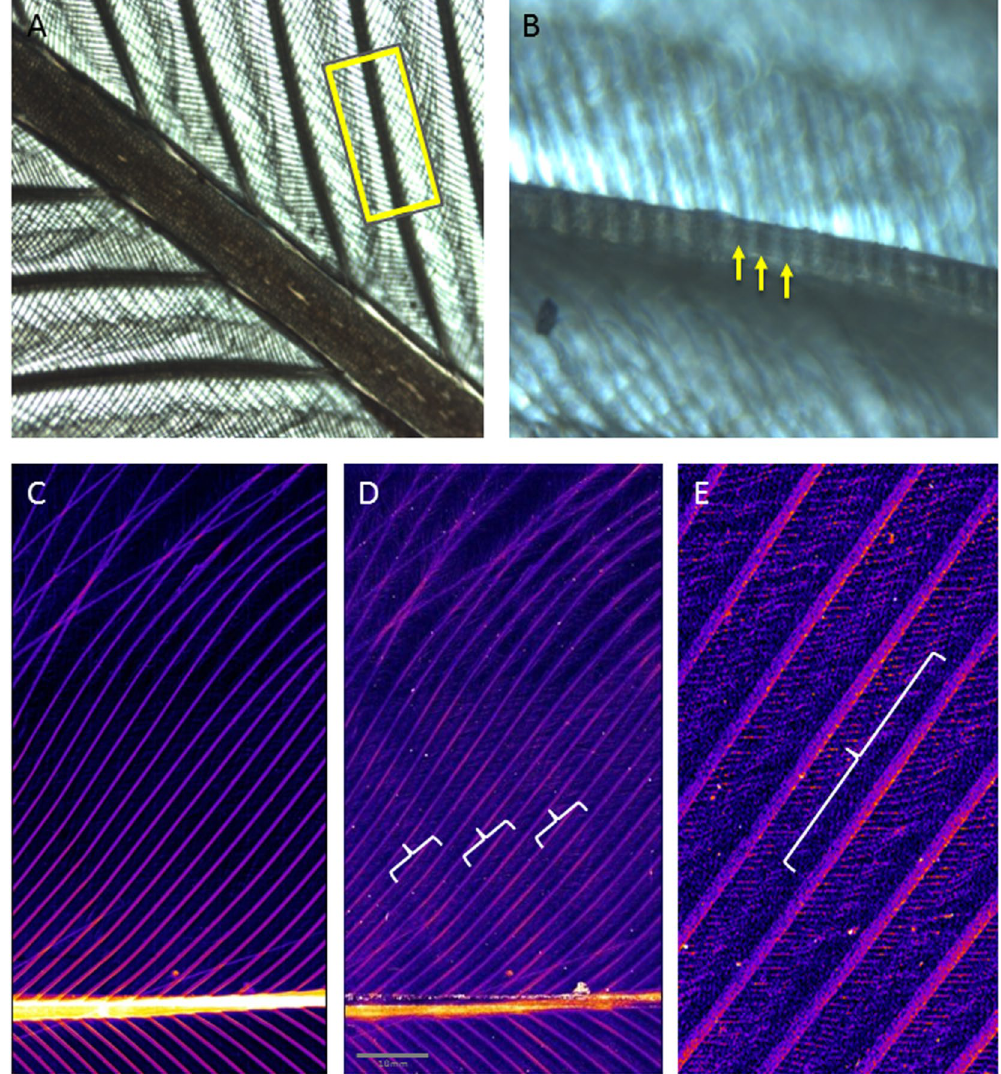
cies, including Dromaius novaehollandiae (Emu), Apteryx sp. (Brown Kiwi), Pelagodroma marina (White-faced Storm Petrel), Stagonopleura guttata (Diamond Firetailed Finch), Gallus gallus (Red Junglefowl), Anas platyrhy- nchos (Mallard) and Cygnus atratus (Black Swan) (Suppl. 1) 26 did not reveal the presence of a regular Zn banding pattern. It raises the prospect that the study of hidden elemental distribution patterns, unrelated to the visible and behaviourally salient pigmentation of bird feathers, may be useful in the clarification of some evolutionary lineages and relationships 27